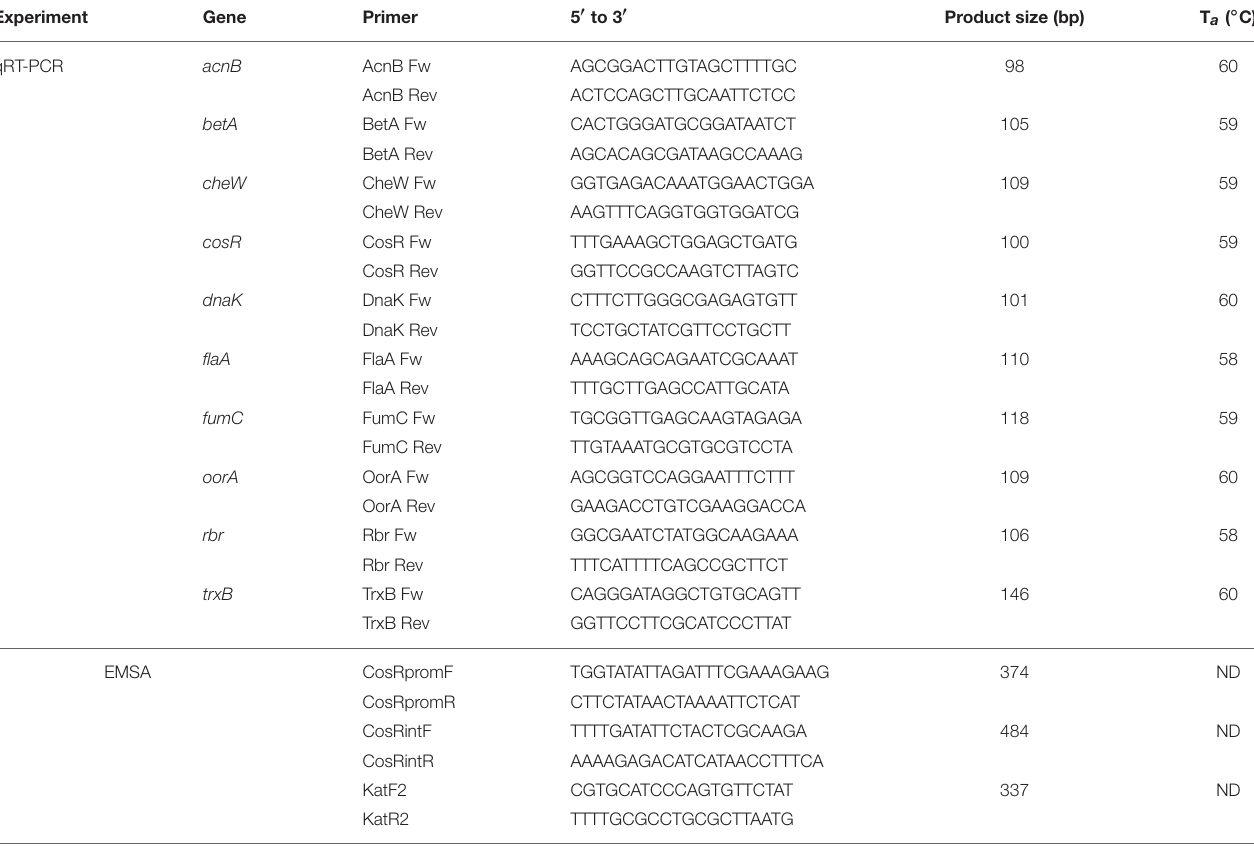
TABLE 1 | Primers used in the experiments.